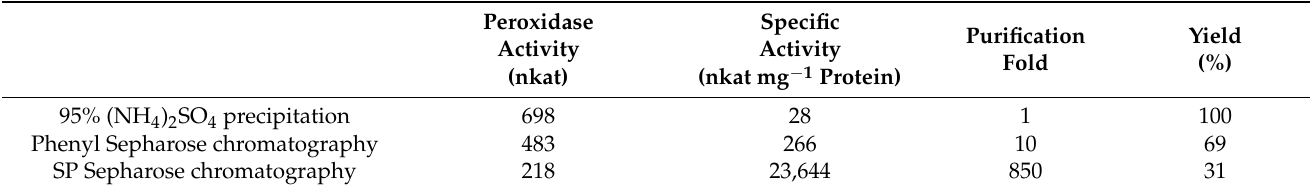
Table 1. Purification of basic peroxidase PpaPrx19 from P. patens . Peroxidase activity was measured using TMB as substrate.